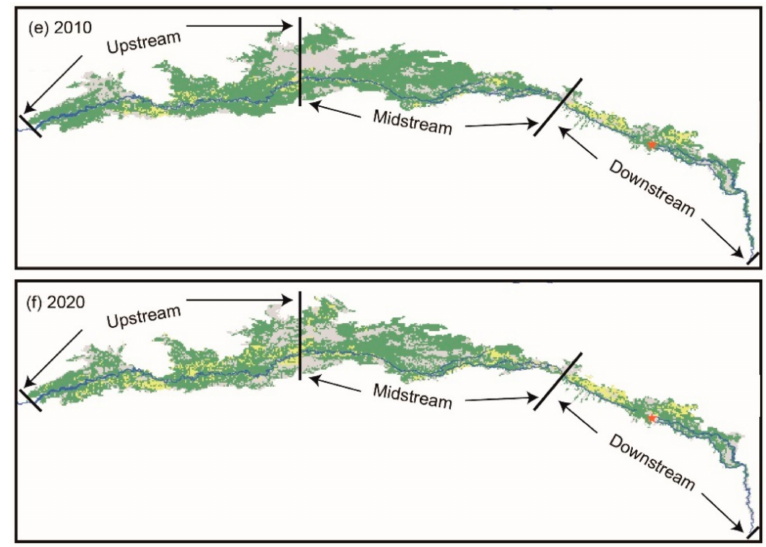
Figure 3. Spatial distribution of the irrigated land, natural vegetation, and other areas in the upstream, midstream, and downstream of the Tarim River Basin between ( a – f ) 1970 and 2020.